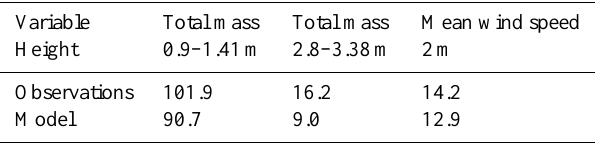
Table 3. Total snow mass (kgm − 2 ) transported at two levels above the snowpack and mean wind speed (ms − 1 ) observed and simulated at the location of SPC. Total snow mass represents the cumulative blowing snow flux over the period of snow transport.